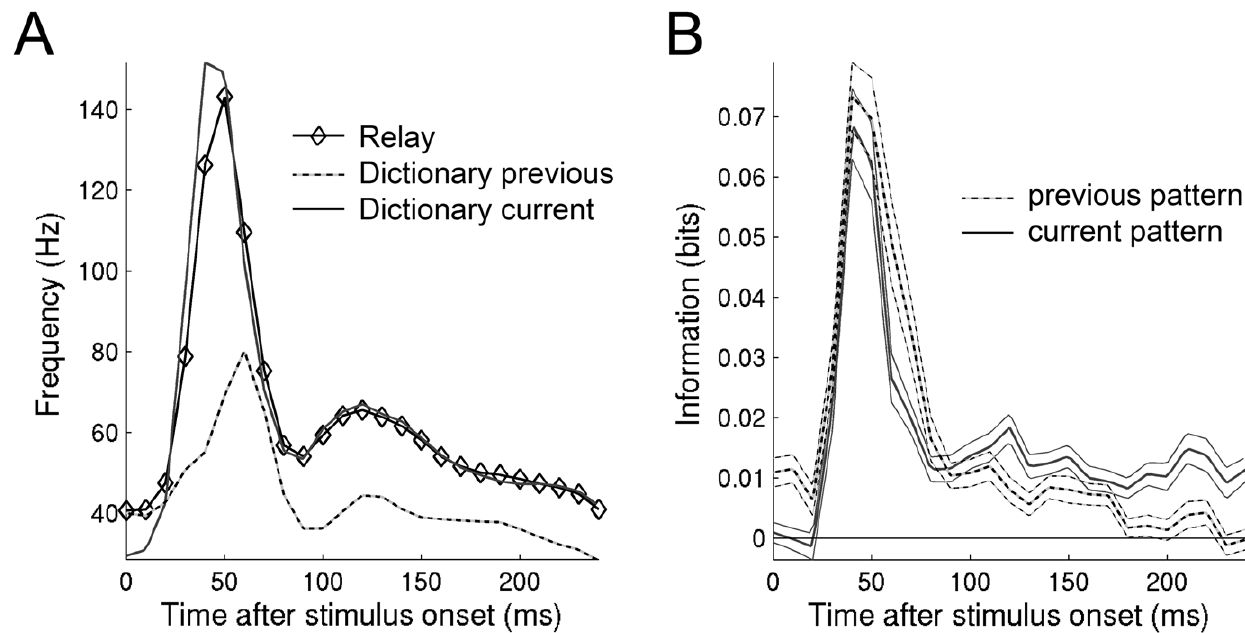
Figure 4. The difference image is encoded by the spikes that convey maximal information about current image. A: The average instantaneous firing rate for a pattern to pattern transition, a blank to pattern transition and a pattern to blank transition. B: The information about the current and previous stimulus was calculated in 10 ms bins. Initially the information about the previous stimulus is larger than the information about the current stimulus. After 100 ms the opposite is true.